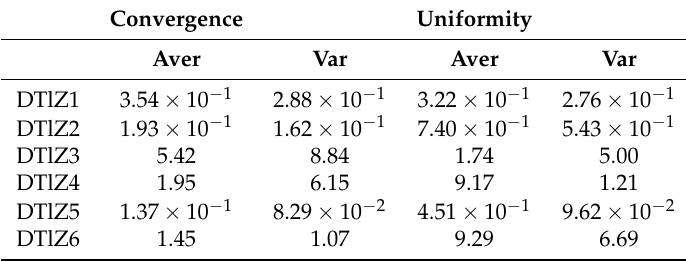
Table 6. Convergence index and Spacing index for the DTLZ